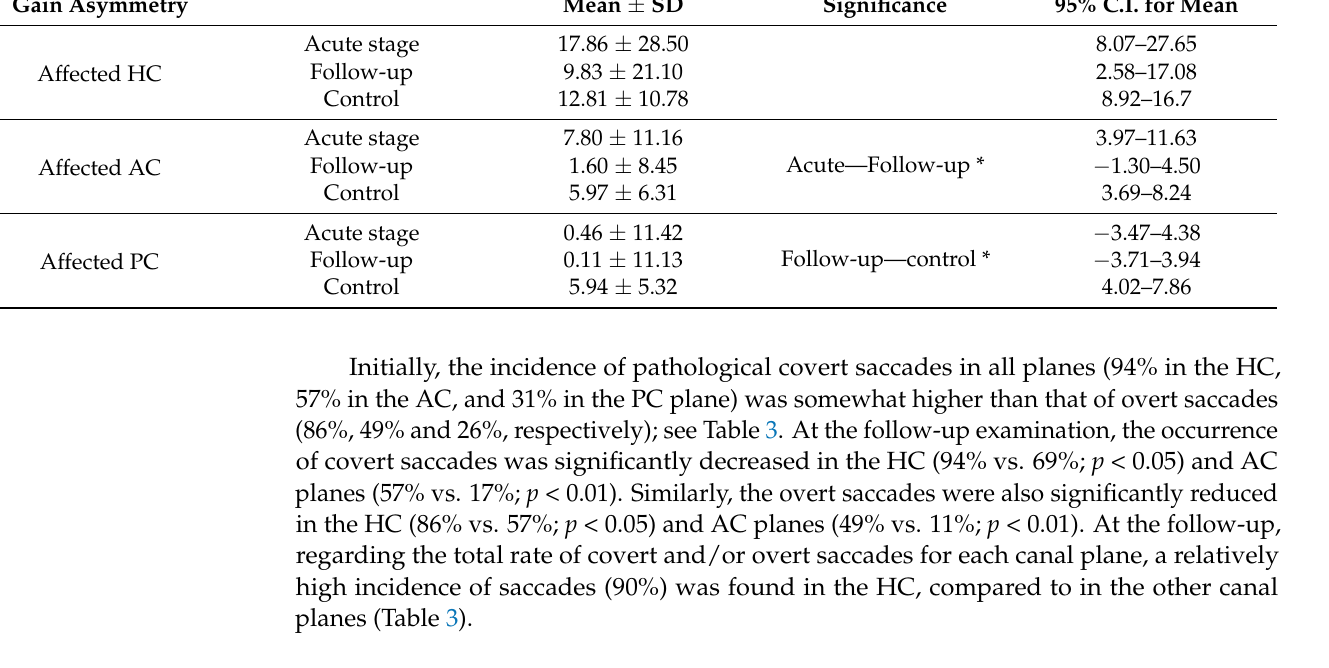
Table 3. Incidence of pathological covert and overt saccades during vHIT in patients suffering from vestibular neuritis at the acute stage and follow-up affected side. HC: horizontal canal plane,